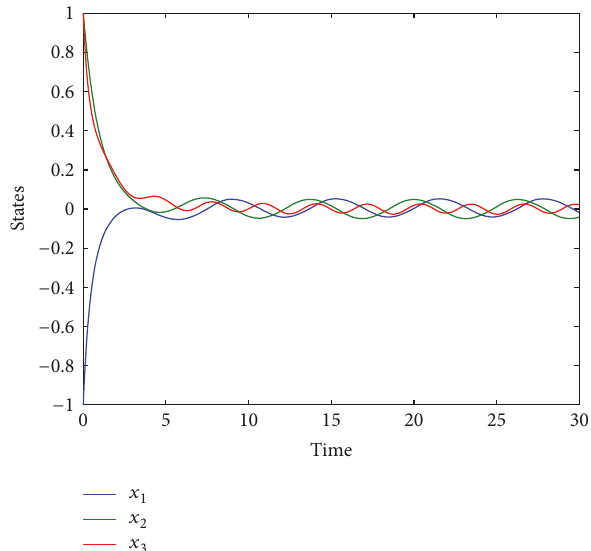
Figure 1: The state trajectories of system (1) with 𝑥(0) = (−1,1, 1) 𝑇